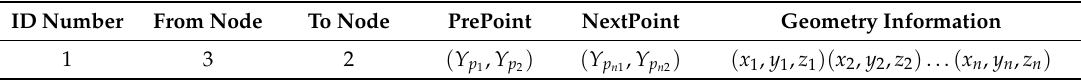
Table 1. The pipe line structure in the network data set.